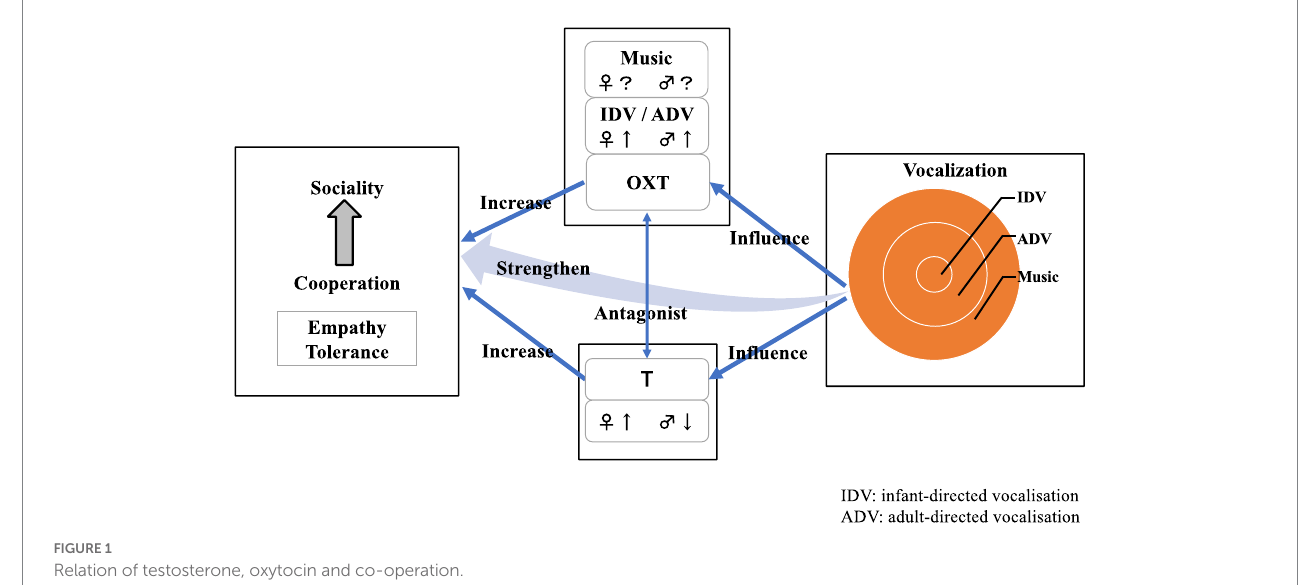
FIGURE 1 Relation of testosterone, oxytocin and